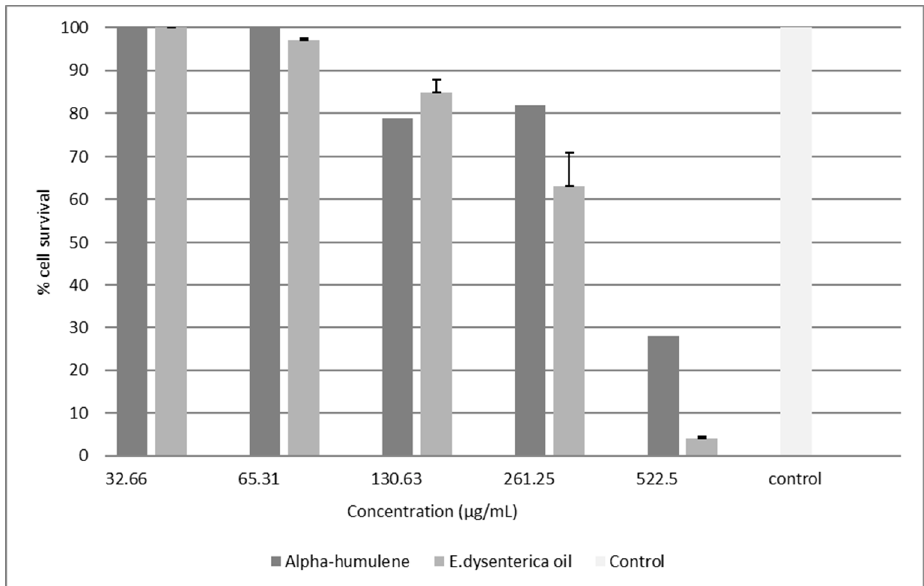
Figure 3. Viability of cells treated with an essential oil from the leaves of E. dysenterica and α humulene after 24 h of treatment in a microphages cell line RAW by MTT assay. Macrophages cell without treatment was used as control.